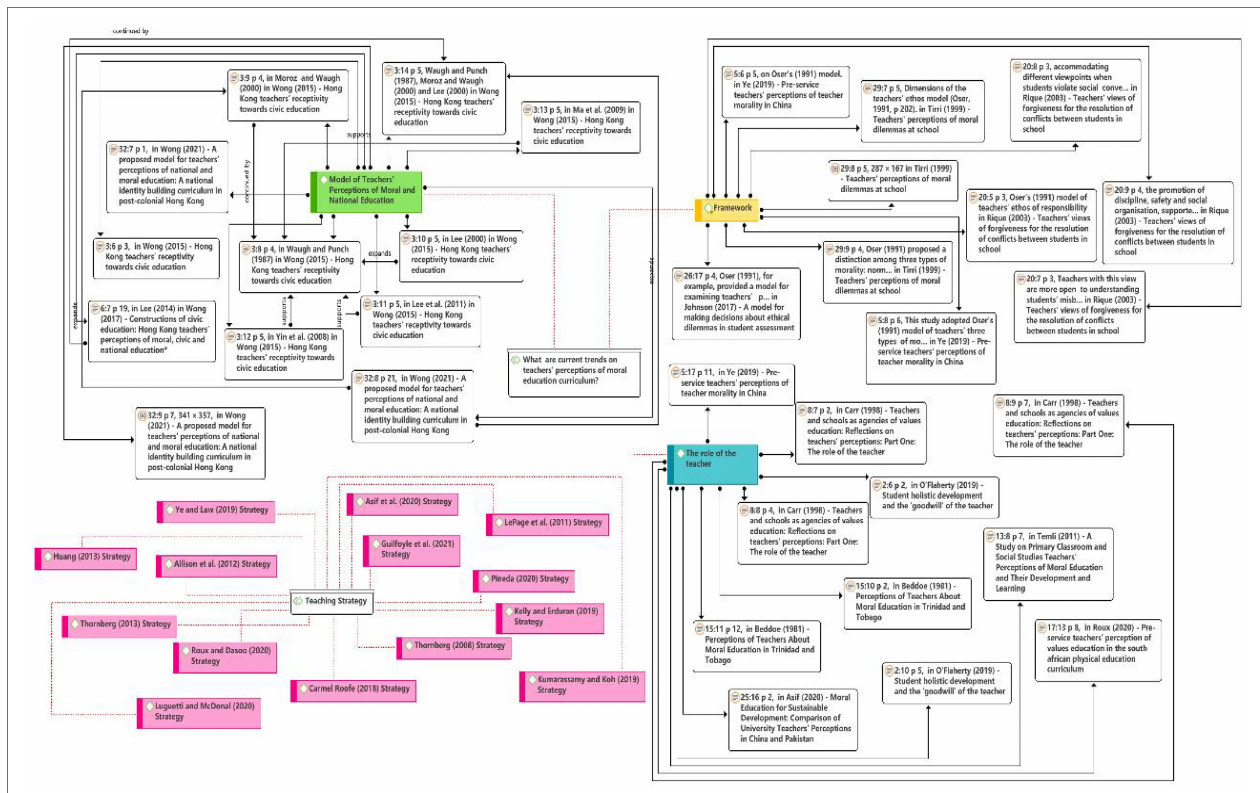
FIGURE 4 | The overall thematic review